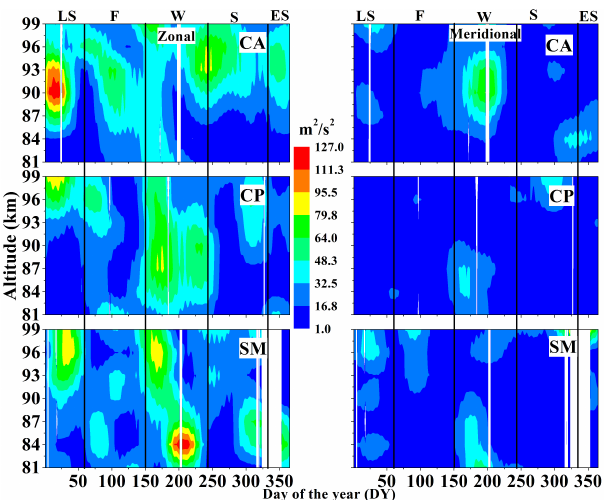
Figure 4. Wavelet power spectra estimated at 10hPa pressure level using ECMWF zonal and meridional winds at CA, CP, and SM. The bold curves represent 95% confidence